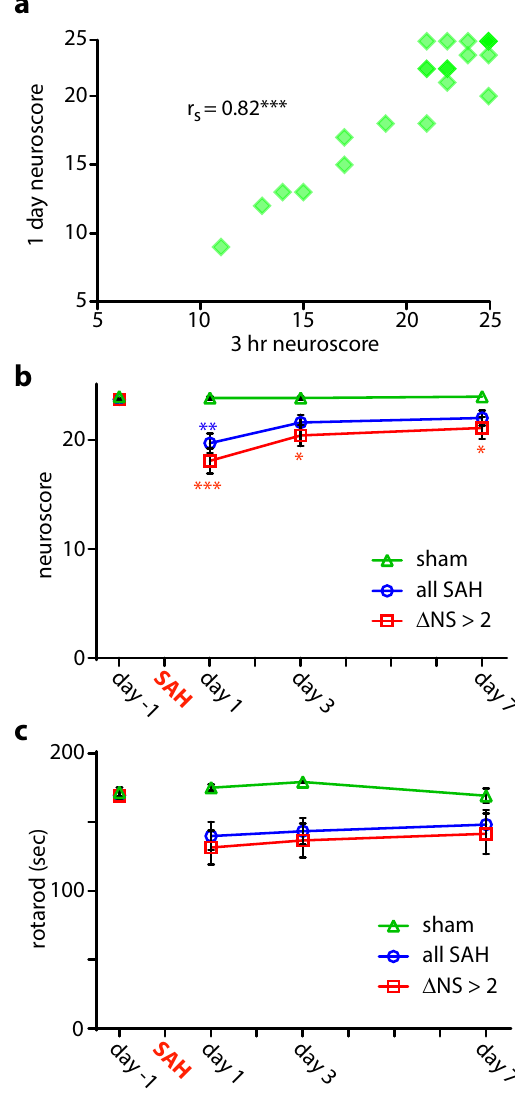
Figure 2. Acute and sub-acute sensorimotor impairment. Neuroscore (NS) collected 3 hours after injury compared with that measured at 1 day post-injury ( a ). NS ( b ) and rotarod ( c ) evaluation one day before and at days 1, 3, and 7 post-injury. Only animals meeting inclusion criteria (NS > 22 and RR ≥ 140) are depicted. Spearman correlation ( a ). Mann-Whitney U test with Holm-Bonferroni correction for multiple comparisons ( b , c ). RR before correction for multiple comparisons; day 1: P = 0.30 sham vs. all SAH, P = 0.14 sham vs. Δ NS > 2; day 3: P = 0.06 sham vs. all SAH, P = 0.05 sham vs. Δ NS > 2; day 7: P = 0.63 sham vs. all SAH, P = 0.54 sham vs. Δ NS >